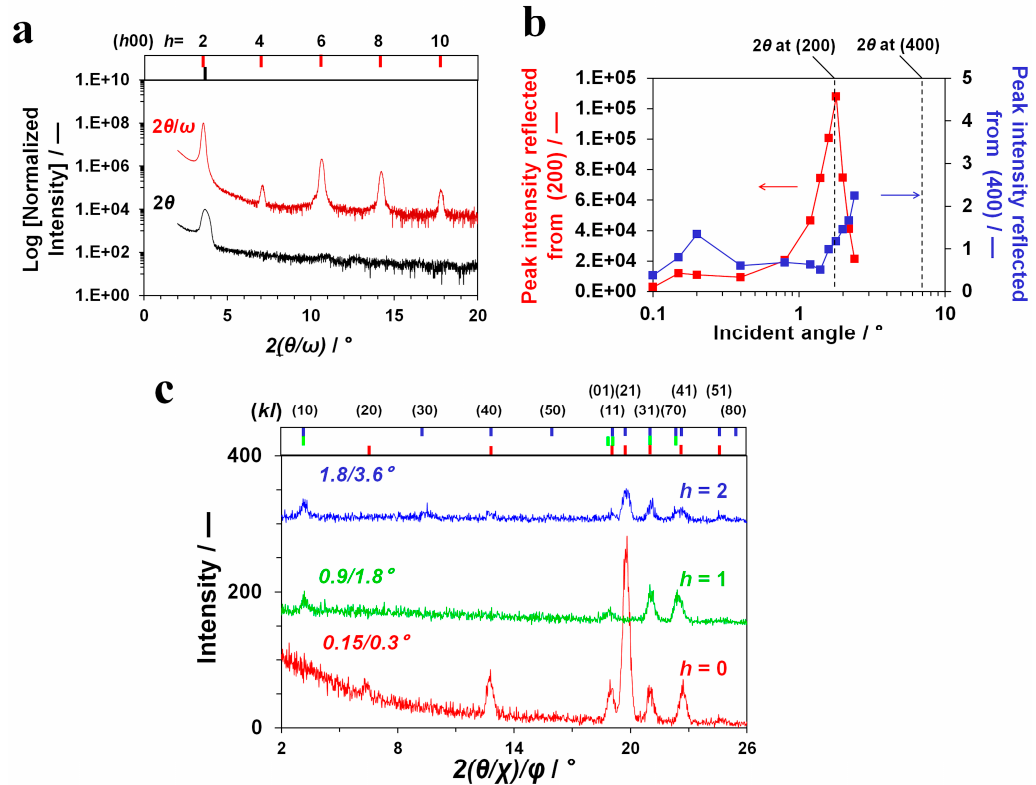
Figure 6. X-ray analyses of 640-nm-thick MO β Gal hemihydrate crystalline films. ( a ) Out-of-plane profiles. Comparison of profiles obtained with 2 θ / ω and 2 θ scans using an incident angle of 0.15 ◦ . ( b ) Peak intensities at the (200) and (400) reflections vs. incident angles. ( c ) In-plane profiles. The angles of (incident/detected) in the 2 θ range are noted inside the figure.